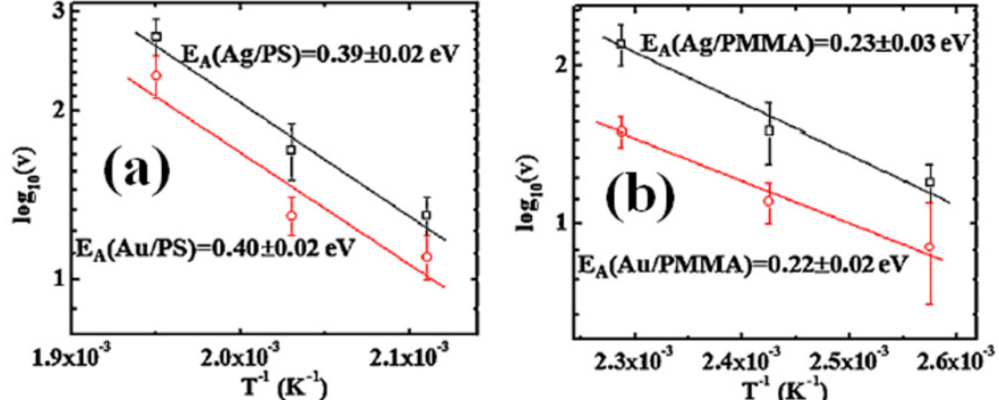
Figure 18. Evolution Arrhenius plots of the embedding velocity as a function of the annealing temperature T for the Ag/PS and Au/PS ( a ), Ag/PMMA and Au/PMMA ( b ) systems. The full lines are the exponential fits of the experimental data. The values obtained for the activation energy are indicated. (Reproduced with permission from [65], Copyright Springer